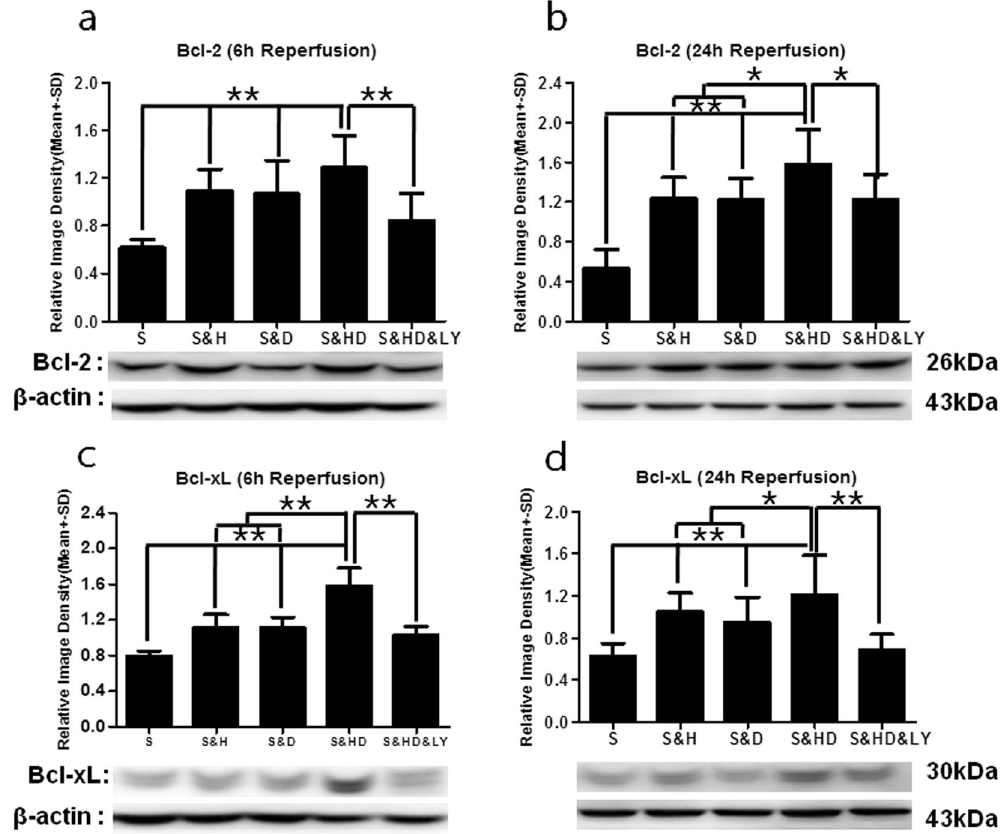
Figure 7. Increase in anti-apoptotic protein expression with mild hypothermia and C + P combination therapy. A significant decrease ( * P < 0.05) in Bcl-2 levels was seen after ischemic stroke (S) at both ( a ) 6 h (n = 6 per group) and ( b ) 24 h (n = 6 per group) of reperfusion. Ischemia-induced reduction in Bcl-2 levels was significantly reversed ( ** P < 0.01) with combination therapy (S&HD) at both 6 h ( F (4,25) = 8.216) and 24 h ( F (4,25) = 11.806) of reperfusion. Again, mild hypothermia (S&H) or C + P (S&D) alone only led to a small increase in Bcl-2 expression ( ** P < 0.01). PI3K / Akt inhibitor (S&HD&LY) reversed the combination therapy- induced increase in Bcl-2 levels at 6 h ( ** P < 0.01) and 24 h ( * P < 0.05). Similarly, there was a significant decrease in Bcl-xL levels after ischemic stroke (S) at both ( c ) 6 h (n = 6 per group) ( ** P < 0.01) and ( d ) 24 h (n = 6 per group) ( * P < 0.05) of reperfusion. Although the expression of Bcl-xL was induced by either mild hypothermia (S&H) or C + P (S&D) at both time points ( ** P < 0.01), combination therapy (S&HD) further enhanced Bcl-xL expression ( F (4,25) = 22.272, ** P < 0.01 at 6 h; F (4,25) = 6.728, ** P < 0.01 at 24 h). PI3K / Akt inhibitor (S&HD&LY) reversed the combination therapy-induced increase in Bcl-xL levels ( ** P < 0.01). Representative immunoblots are